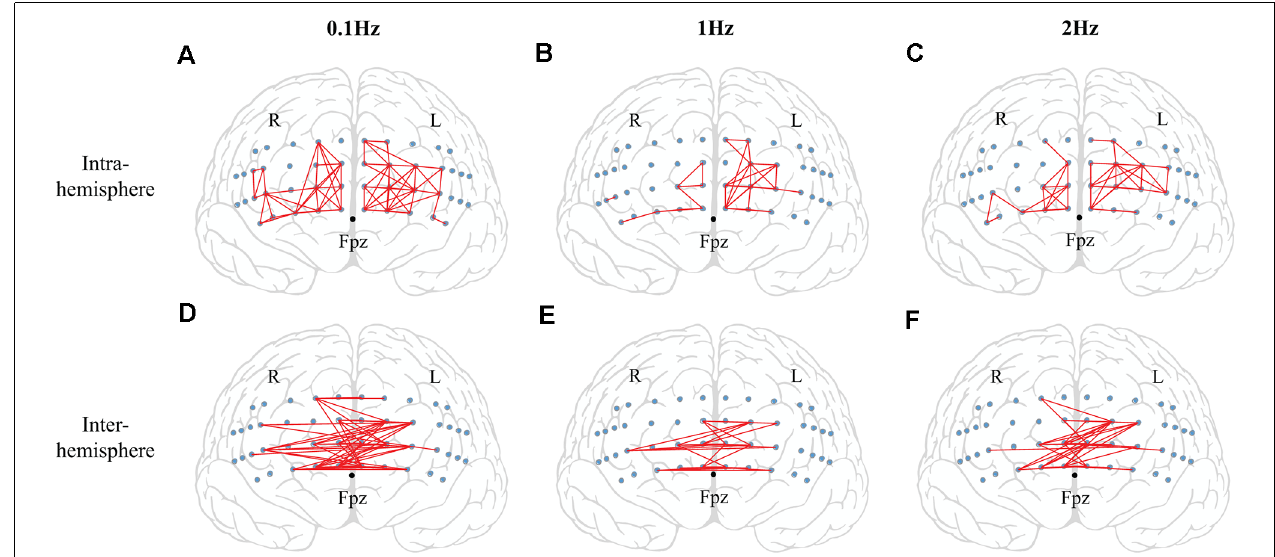
FIGURE 7 | The results of functional connectivity (FC N ). The significant functional connectivity (FC N ) between two channel pairs is shown by red lines. The small blue circles indicate the locations of fNIRS channels. The top panel shows the significant functional connectivity in the intra-hemisphere for 0.1 Hz ( left panel ) (A) , 1 Hz ( middle panel ) (B) , and 2 Hz ( right panel ) (C) conditions. The bottom panel indicates the significant functional connectivity in the inter-hemisphere for 0.1 Hz ( left panel ) (D) , 1 Hz ( middle panel ) (E) , and 2 Hz ( right panel ) (F) conditions.